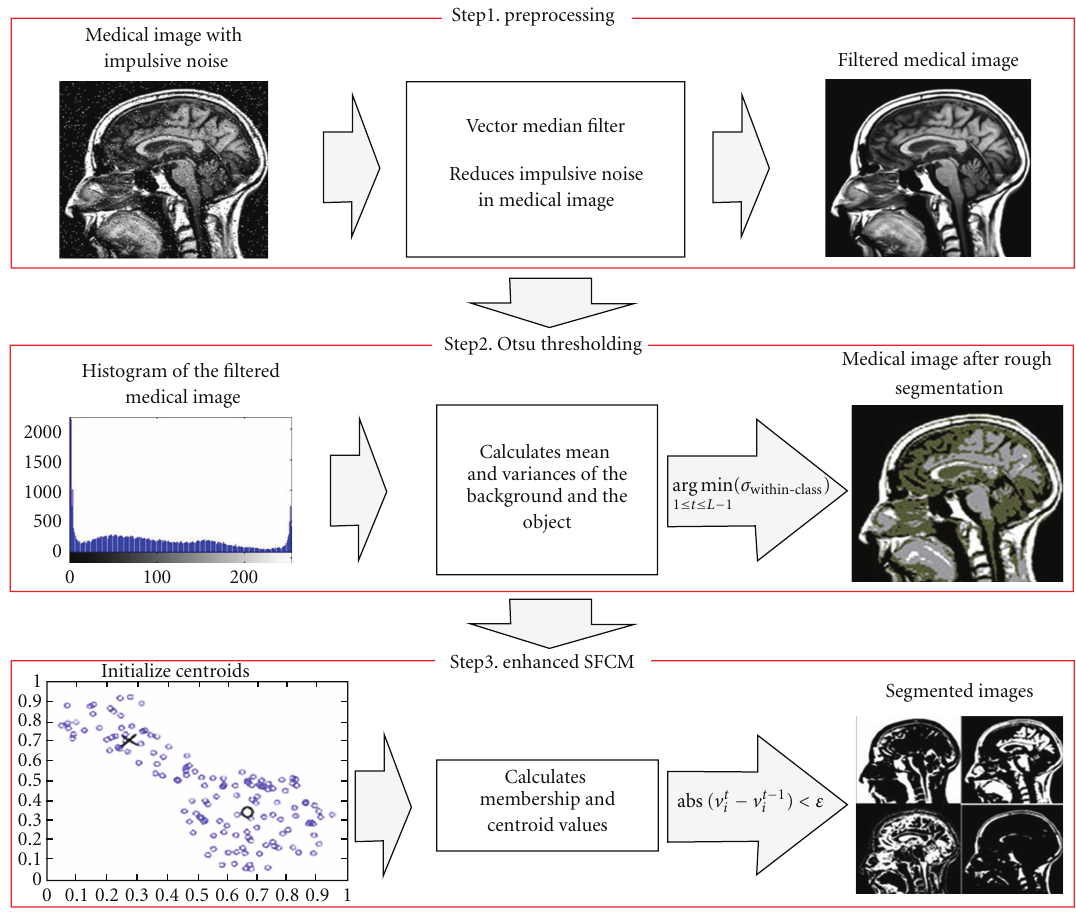
Figure 1: Process of the proposed image segmentation